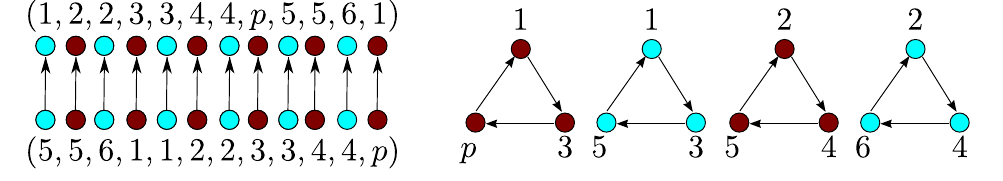
Fig. 7: Two equivalent colored radial orderings and their corresponding